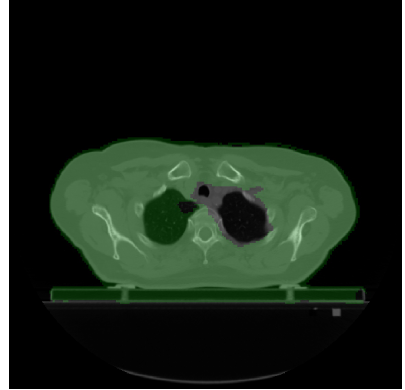
Figure 24. CT images before and after radical radiotherapy (RT) of left lung cancer.